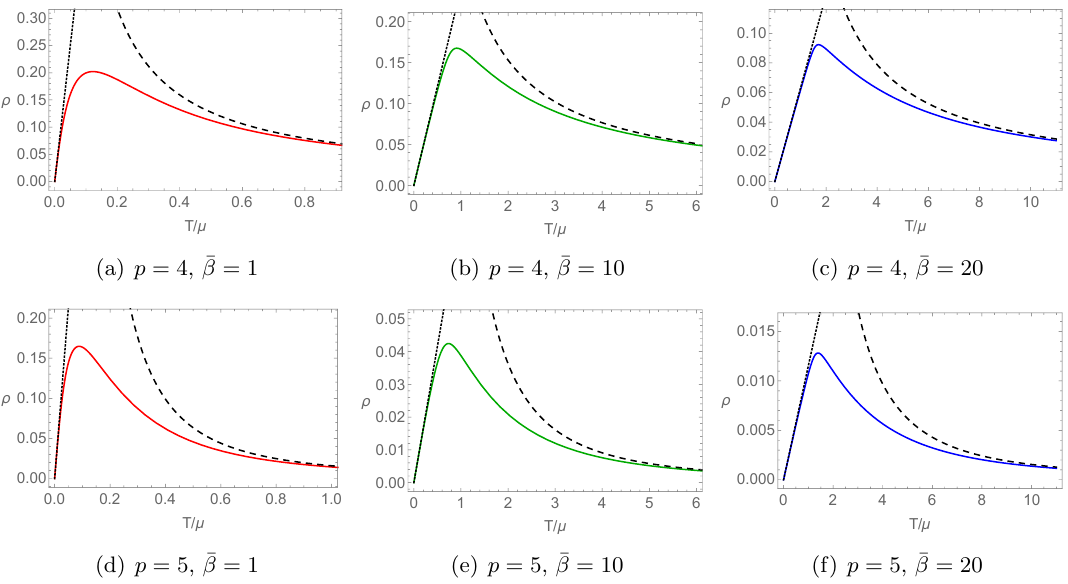
Figure 4 . Resistivity vs temperature at (cid:12)xed (cid:22) (cid:12) = 1 ; 10 ; 20 for p = 4 (top) and p = 5 (bottom). The dashed curves (right side) are the inverse of (3.21). The dotted lines (left side) are the inverse of (3.20) for (cid:22) (cid:12) = 1 ; 10 and the inverse of (3.23) for (cid:22) (cid:12) = 20.